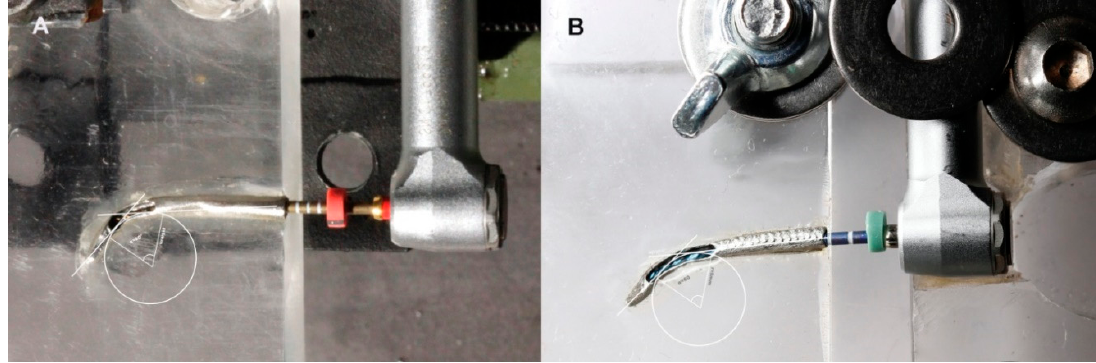
Figure 2. ( A ) ProTaper Gold (PTG) endodontic rotary file inside the 8% taper artificial root canal system and ( B ) ProFile Vortex Blue (PVB) endodontic rotary file inside the 6% taper artificial root